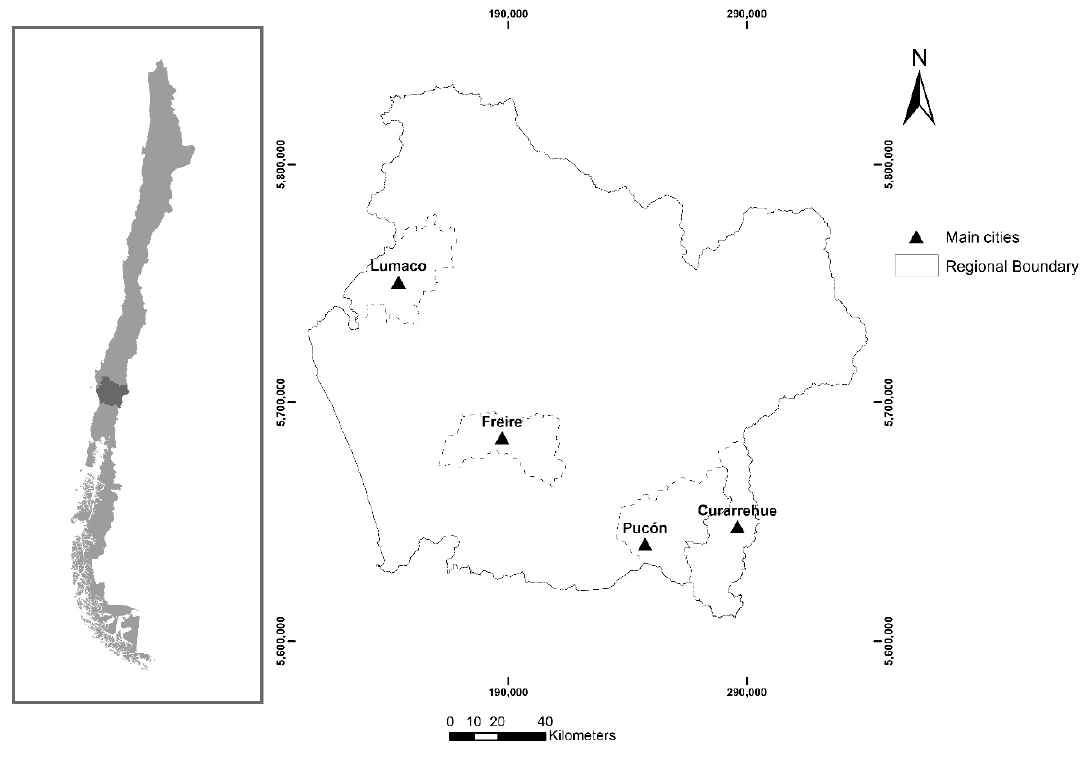
Figure 1. Location of the four landscapes in the La Araucan í a Region, south-central Chile. Table 1. Characteristics of four landscapes in the La Araucan í a Region, south-central Chile.